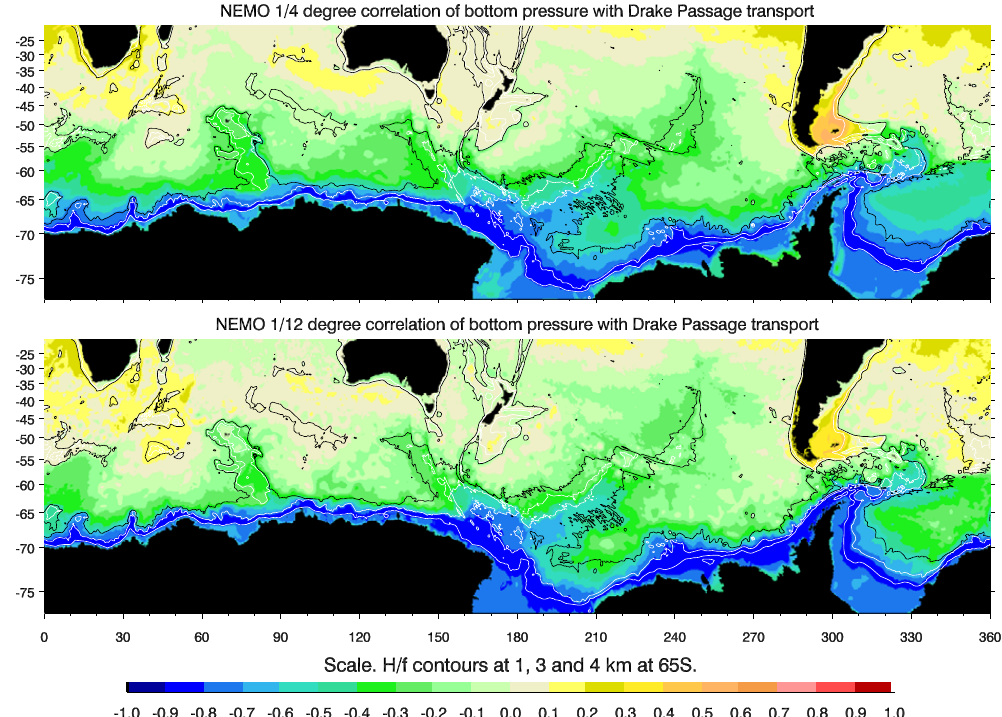
Fig. 2. Correlation between bottom pressure at each point and total flow through Drake Passage, based on (top) 50years of 5-day means in a 1 / 4 ◦ resolution model, and (bottom) 20years of 5-day means in a 1 / 12 ◦ resolution model. All time series have had annual and semiannual cycles and trend removed beforehand. Contours highlight the H/f contours which, at 65 ◦ S, correspond to depths of 1km, 3km (white) and 4km